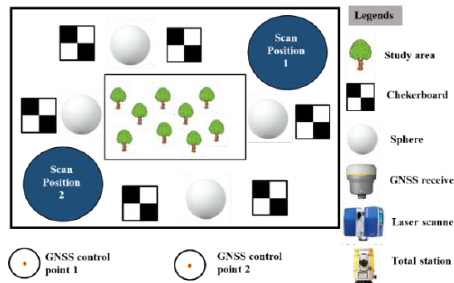
Figure 3 . Experimental setup layout for point cloud data acquisition and georeferencing using LiDAR, GNSS and TS.